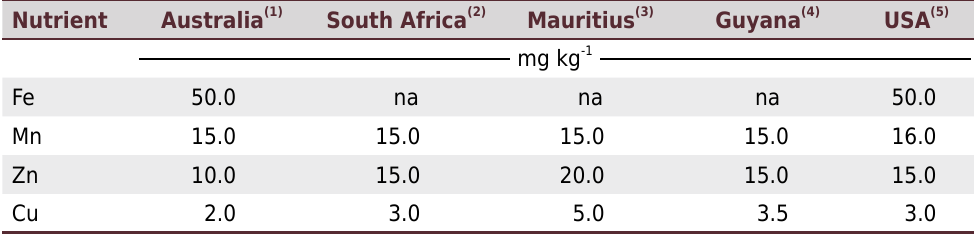
(1) Calcino et al. (2000); (2) Schroeder et al. (1992) and Meyer et al. (1971); (3) Basserau (1987); (4) Evans (1965); (5) McCray and Mylavarapu (2010). na : not